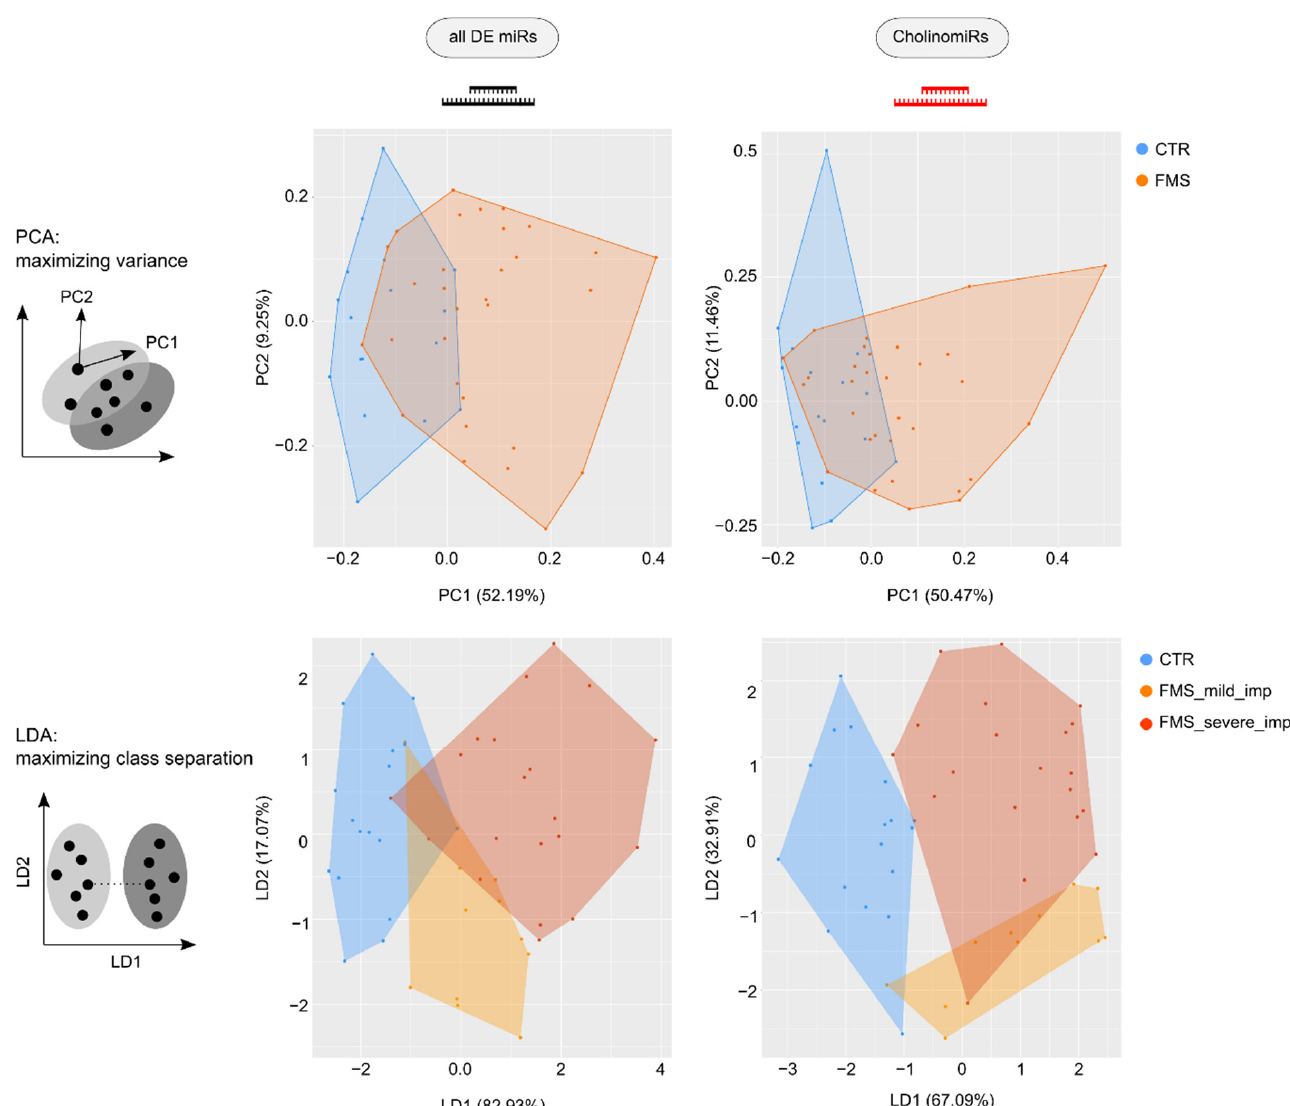
Figure 3. PCA and LDA (principles visualized in grey graphs) for all DE miRs and only CholinomiRs. Although PCA shows only minor improvements in group separation when focusing on CholinomiRs, using LDA with three groups and CholinomiRs leads to high discrimination capacity between healthy controls and FMS patients with mild pain-related daily life impairment (FMS_mild_imp) and severely pain-related daily life impairment (FMS_severe_imp). Abbreviations: CTR, healthy control; DE, differentially expressed; FMS, fibromyalgia syndrome; PCA, principal component analysis.